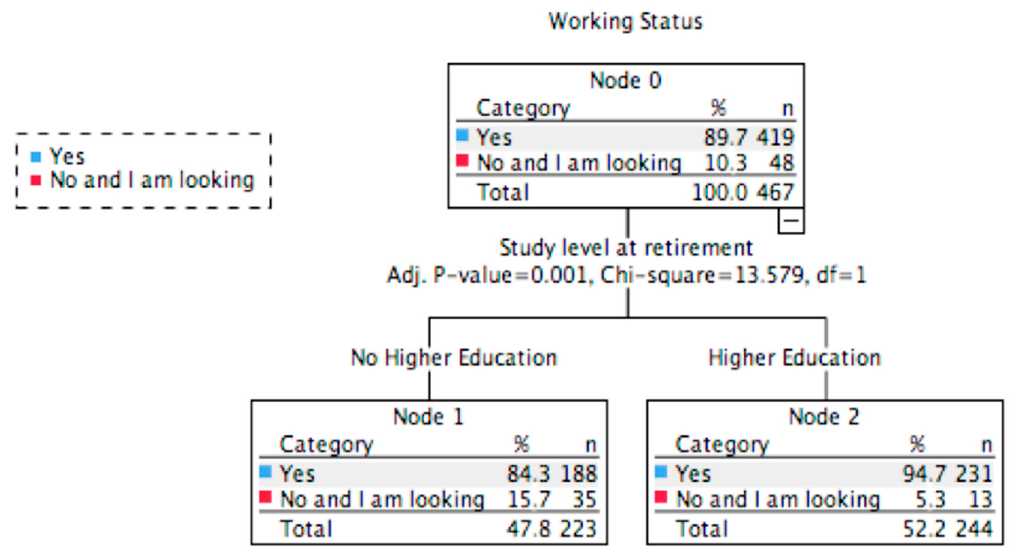
Figure 1. Classification tree analysis of work situation for elite athletes.